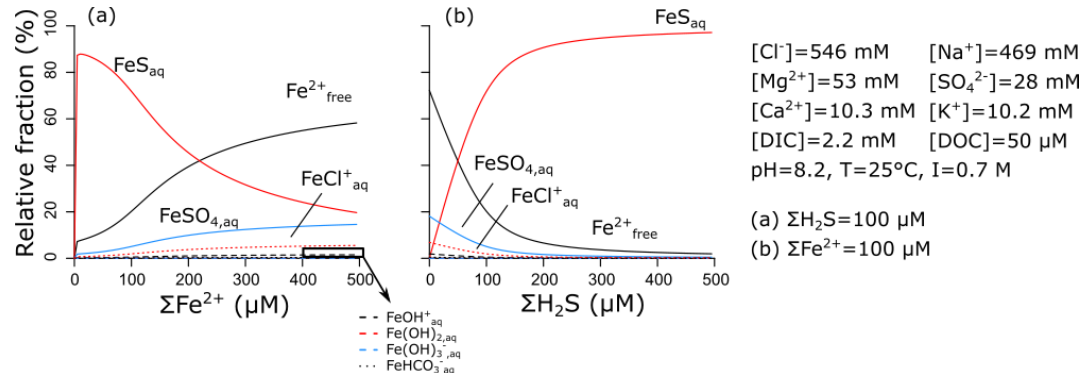
Figure 5. Relative importance of different dissolved Fe complexes, obtained by visualMINTEQ (Gustafsson, 2019). Concentrations of other constituents are chosen to represent average seawater, with the dissolved organic carbon (DOC) concentration from Sharp et al. (1995).